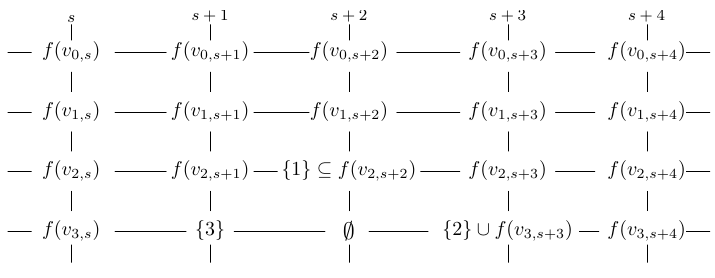
Figure 16. Sketch of f ′ Figure 16. The sketch of f (cid:48) in Lemma 11.